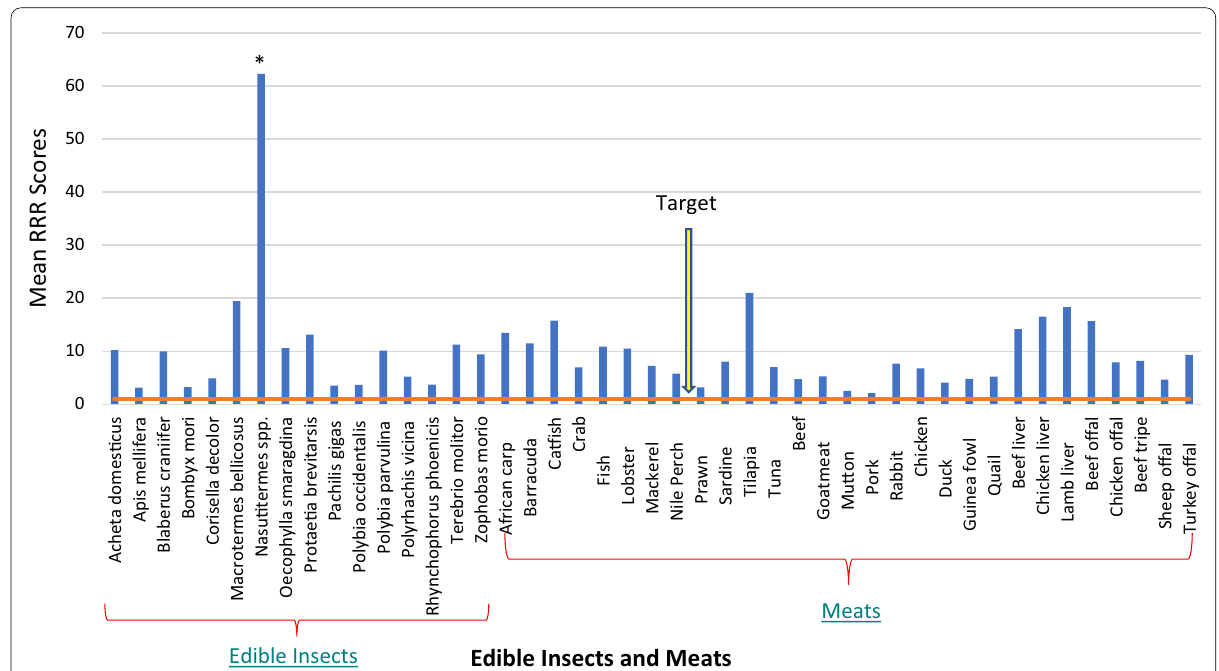
Fig. 2 Bar chart showing mean RRR scores for meats and edible insects. * Nasutitermes spp. was significantly more healthful than all other foods except Macrotermes bellicosus and tilapia ( P <